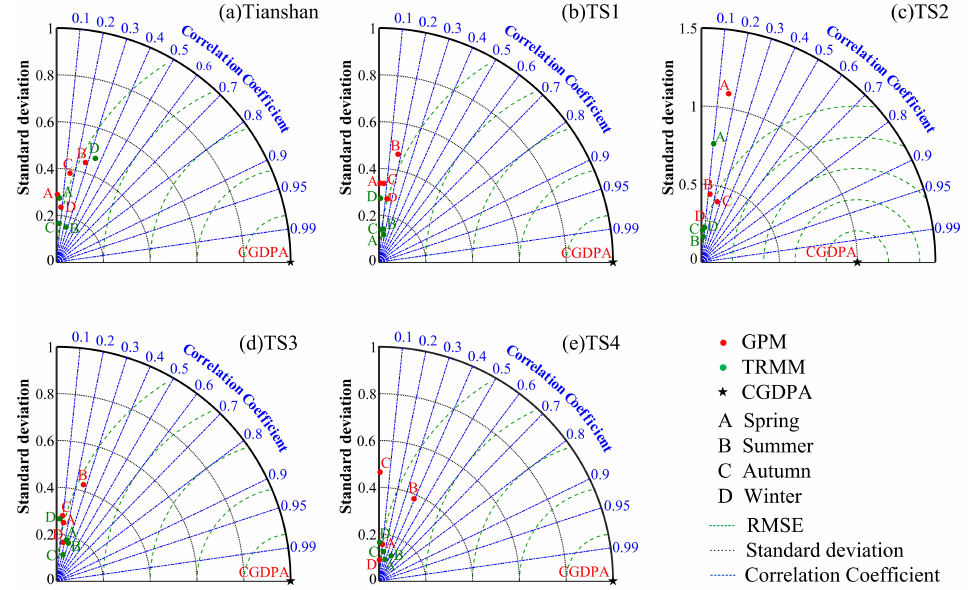
Figure 7. Taylor diagrams for the seasonal variation of precipitation in the TSM and the four